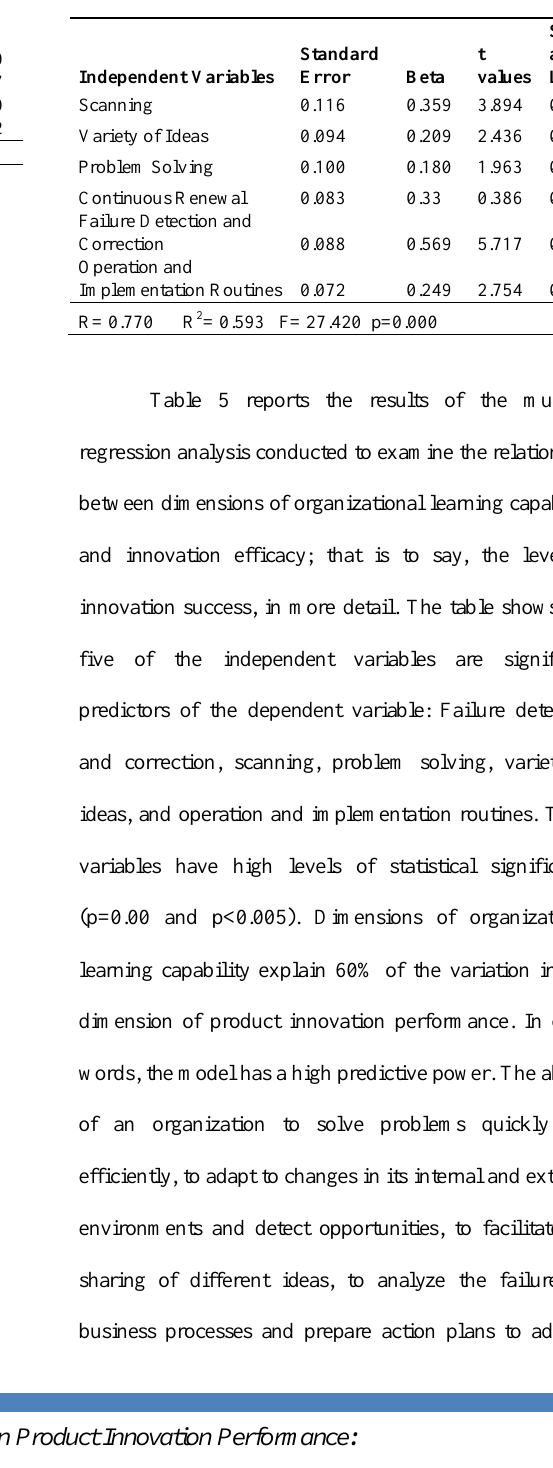
Table 5: Results of the Multiple Regression Analysis between Dimensions of Organizational